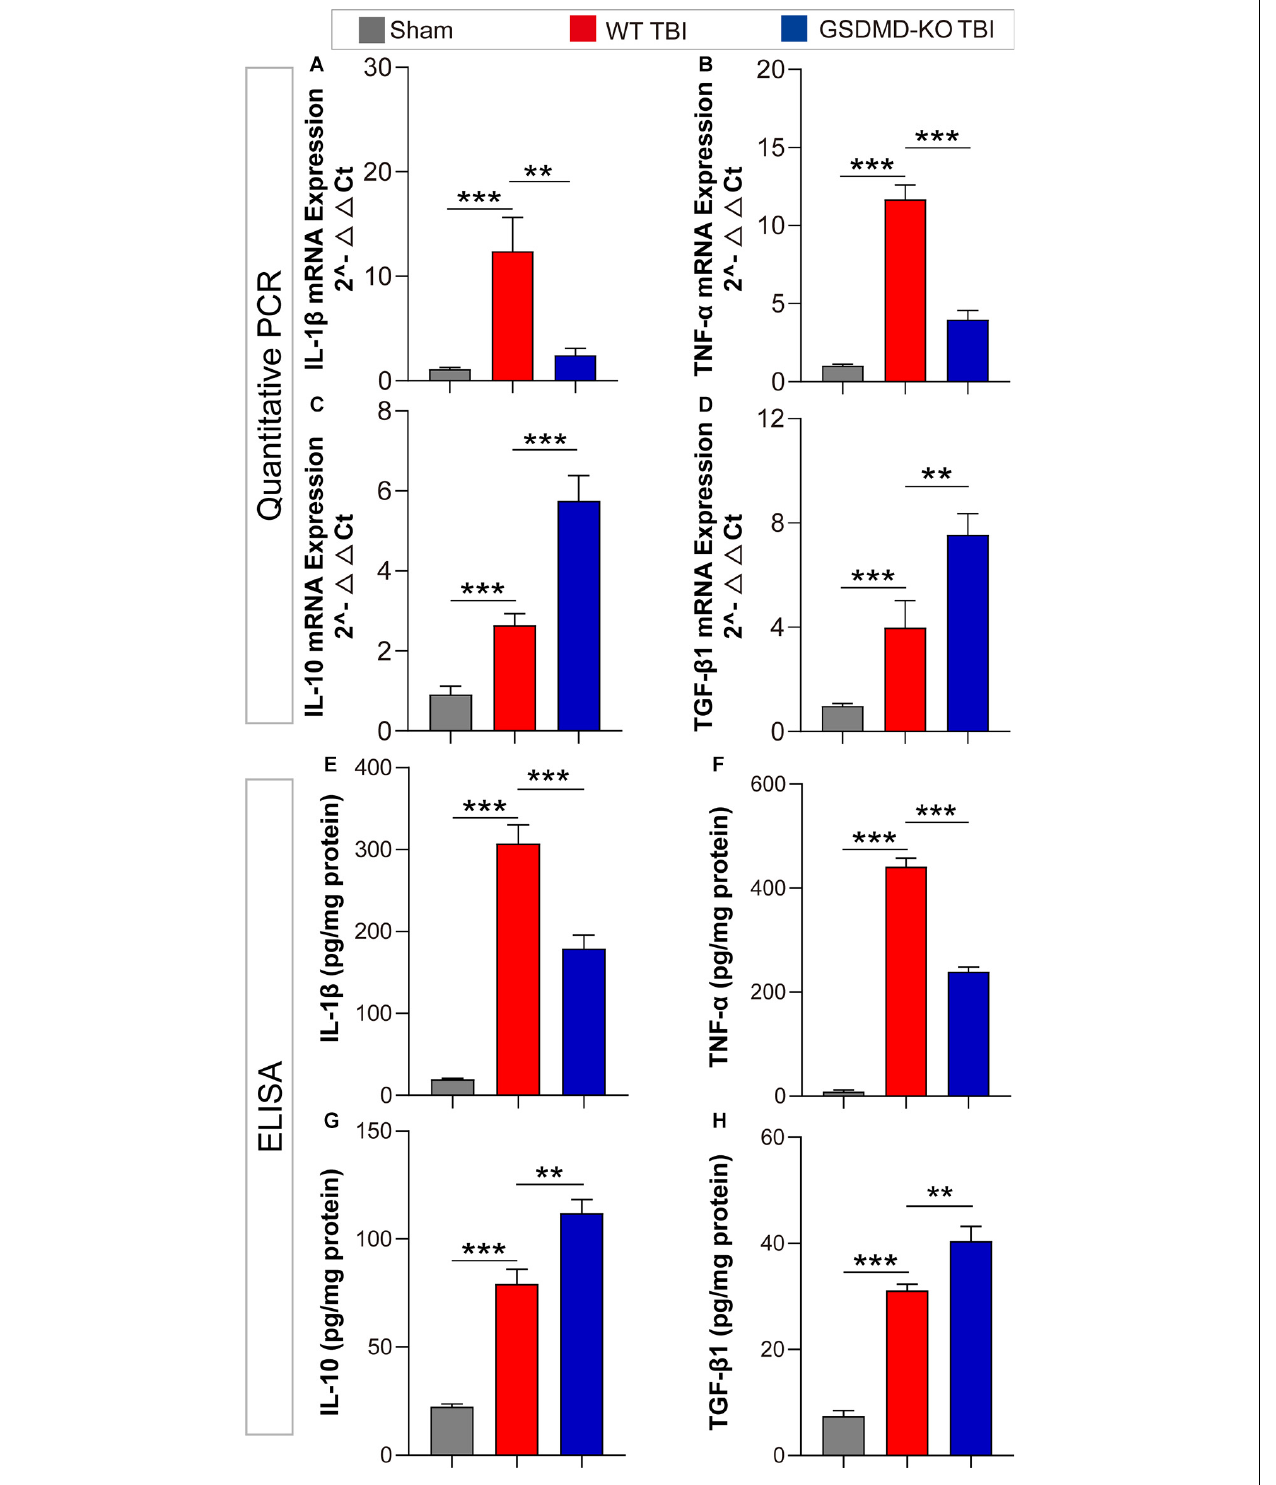
FIGURE 4 | GSDMD-KO diminished pro-inflammatory cytokine release but enhanced anti-inflammatory cytokine release at 3 days after TBI. (A–D) Quantitative analysis of IL-1 β , TNF- α , IL-10, and TGF- β 1 mRNA levels detected by qPCR ( n = 7–8). (E–H) Quantitative analysis of IL-1 β , TNF- α , IL-10, and TGF- β 1 levels in the cortex lysates detected by ELISA ( n = 6). All data are presented as the mean ± SEM and were analyzed using one-way ANOVA followed by Tukey’s multiple comparisons test for significance. ** p < 0.01 and *** p < 0.001.